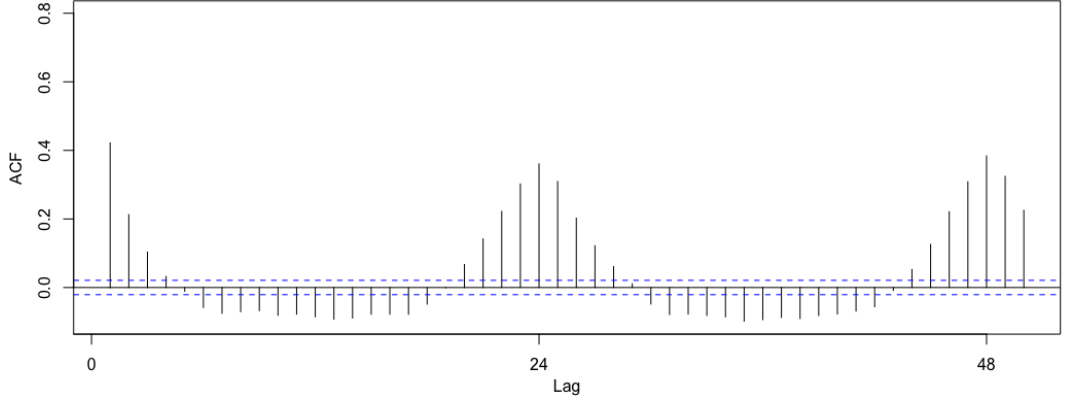
Figure 7. Autocorrelations for smart-meter 92 along